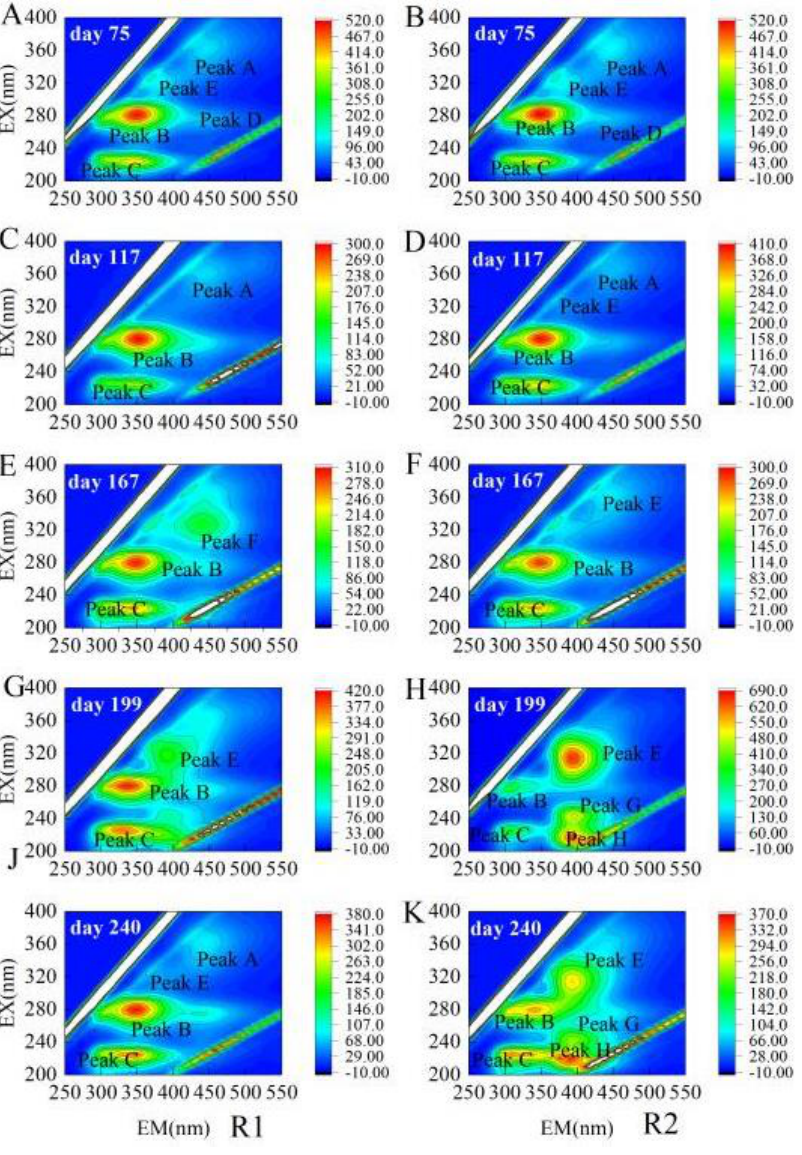
Figure 8. EEM spectra for TB − EPS of aerobic granular sludge in R1 and R2. ( A , C , E , G , J ) for R1; ( B , D , F , H , K ) for R2.